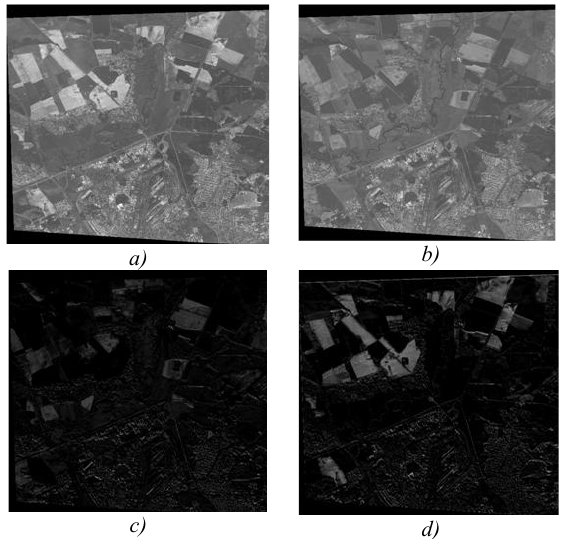
Figure 2. Multitemporal satellite images ( a , b ) and a complementary pair of differential image ( c - increasing brightness, d - decreasing)